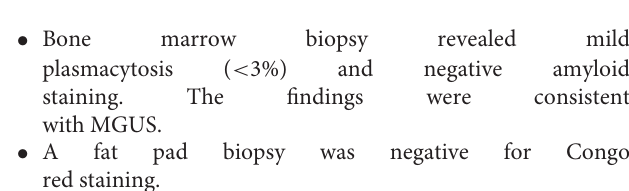
microglobulin was high at 4.91 mg/dL. Urine immunofixation was normal. Serum free kappa light chain level was 152.26 mg/L, free lambda light chain levels were 36.54 mg/L, and the serum kappa/lambda ratio was 4.17. Marked elevation of the free light chain kappa/lambda ratio was